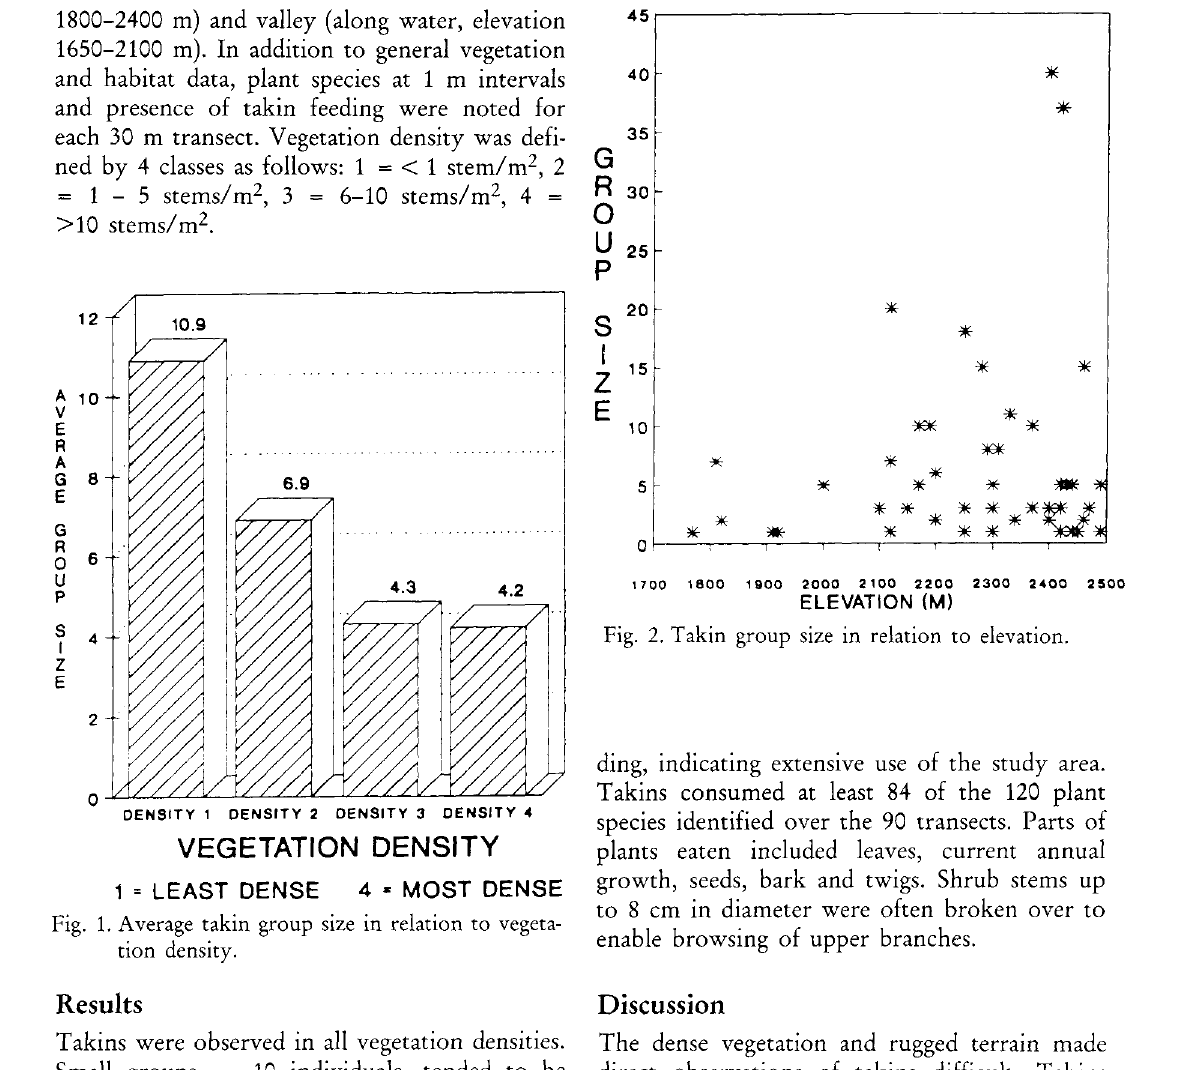
ding, indicating extensive use of the study